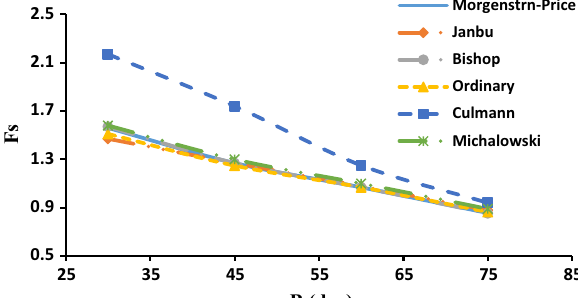
s for condition of � = 14 ◦ , C = 15kN/m 2 ,